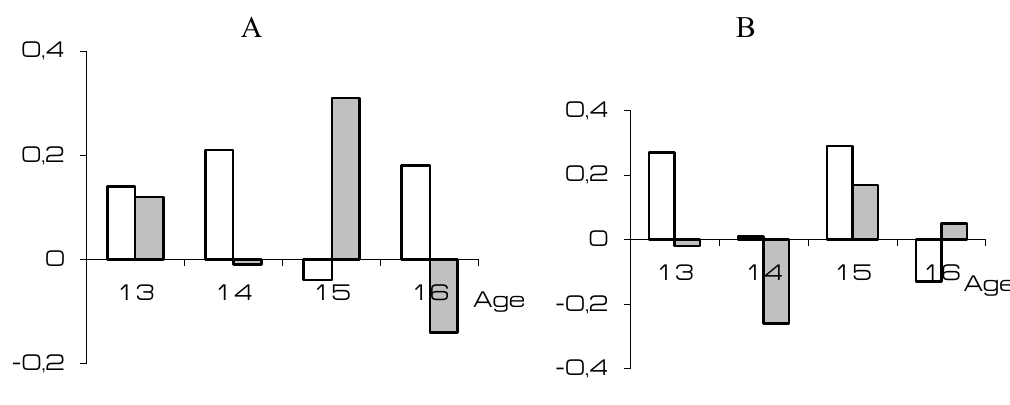
Fig. 3. Correlation between Physical Development Coefficient and Amount of Short-Term Memory for - Numbers, - Figures among Boys (A) and Girls (B) Aged 13-16